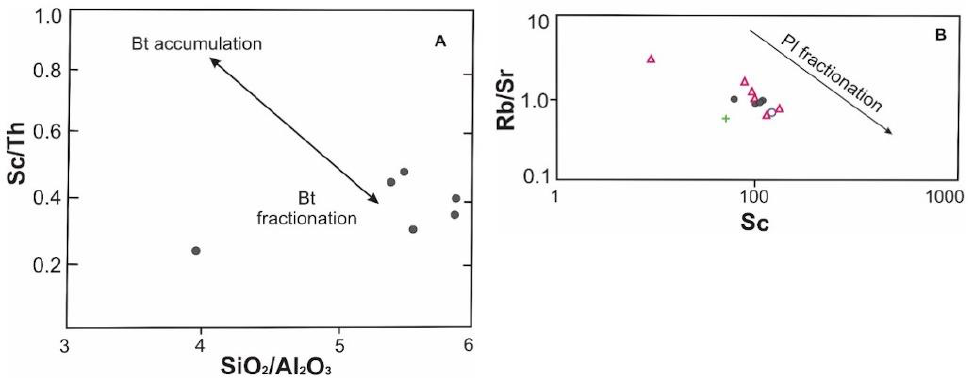
Figure 12. ( A ) Sc/Th vs. SiO 2 /Al 2 O 3 relations showing the biotite fractionation and accumulation trends, adopted from [68], and ( B ) Rb/Sr vs. Sr relations showing feldspar fractionation, after [68].